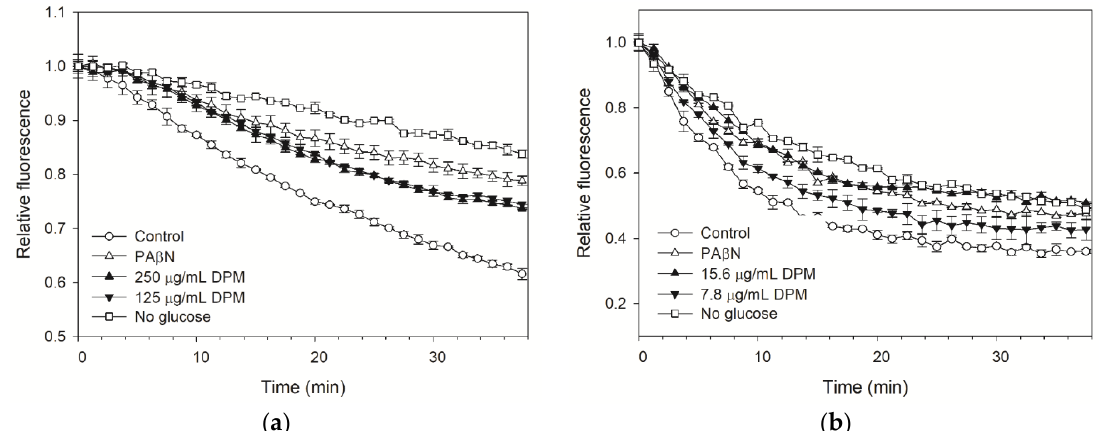
Figure 3. The ( a ) H33342 and ( b ) EtBr efflux assay with diphenylmethane in E. coli Kam3-AcrB. Dye was added to the drug-resistant E. coli cells, which were energized with glucose in the presence of DPM. H33342 (3 µM), EtBr (3 µM), glucose (25 mM), PAβN (20 µg/mL), and DPM. Data are expressed as mean ± SD ( n = 3).